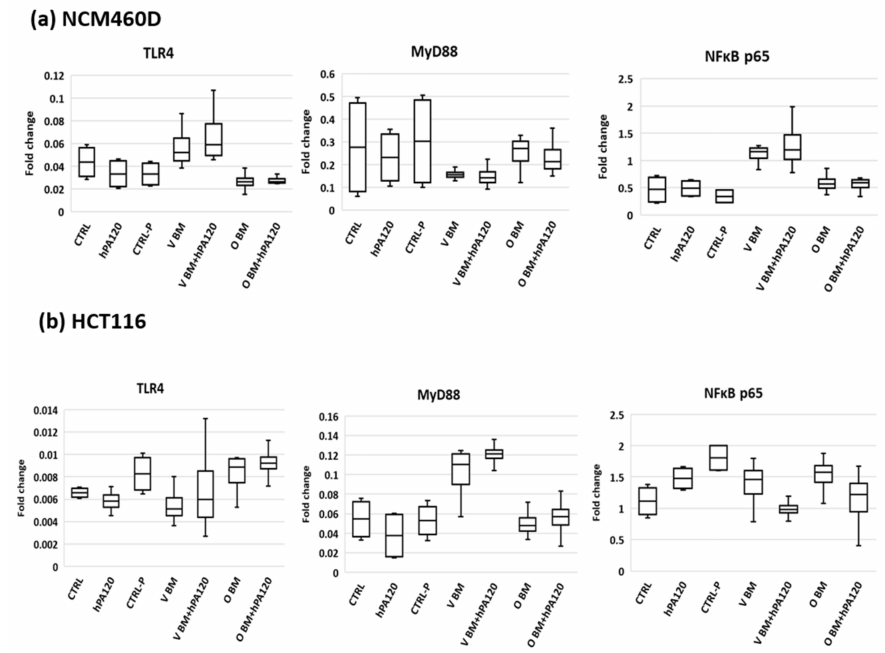
Figure 4. Protein expression of TLR4, MyD88 and NF κ B p65 in ( a )—healthy (NCM460D) and ( b )—cancer (HCT116) colonocytes. Fecal bacteria derived from vegan (V) and omnivorous